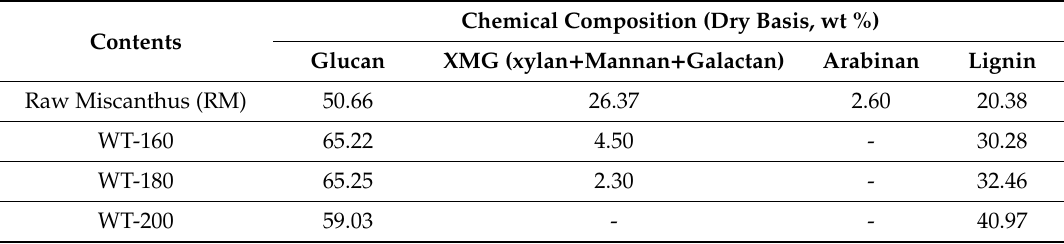
Table 2. Carbohydrate analysis results of raw miscanthus (RM) and wet torrefaction (WT)